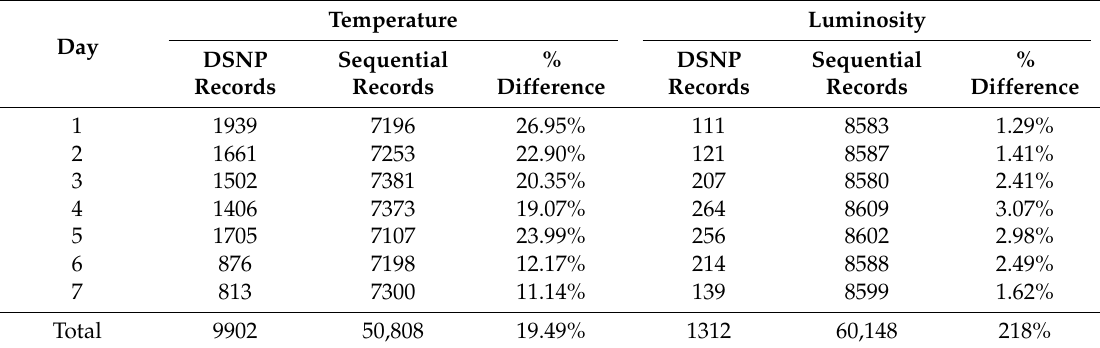
Table 1. Relation of recordings due to the sequential and DSNP methods by